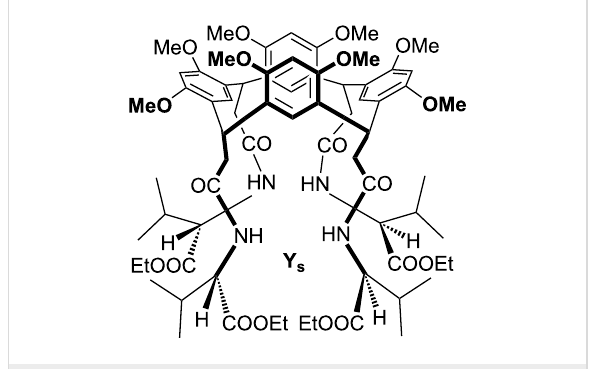
Figure 3: Amidoresorcin[4]arene Y S .